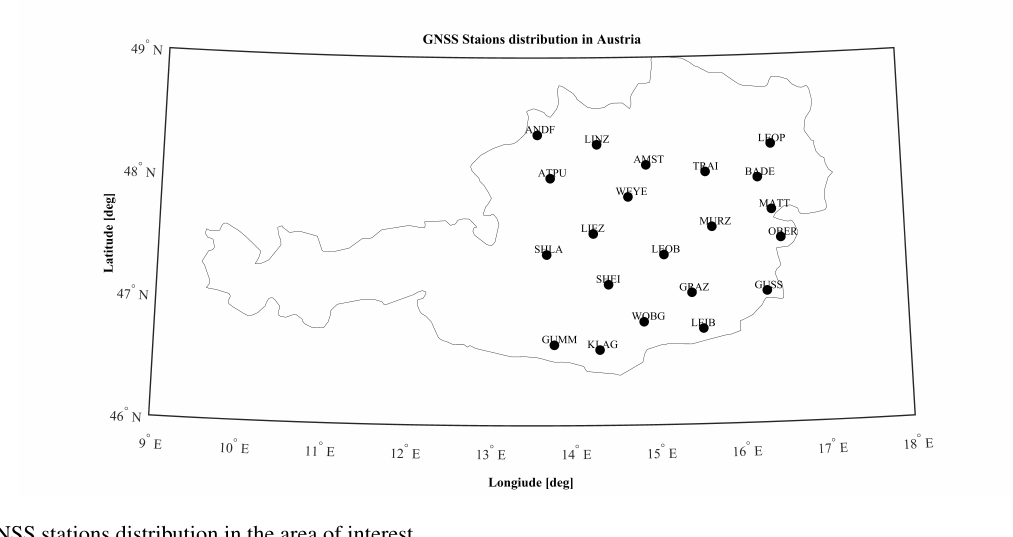
Figure 2. GNSS stations distribution in the area of interest.